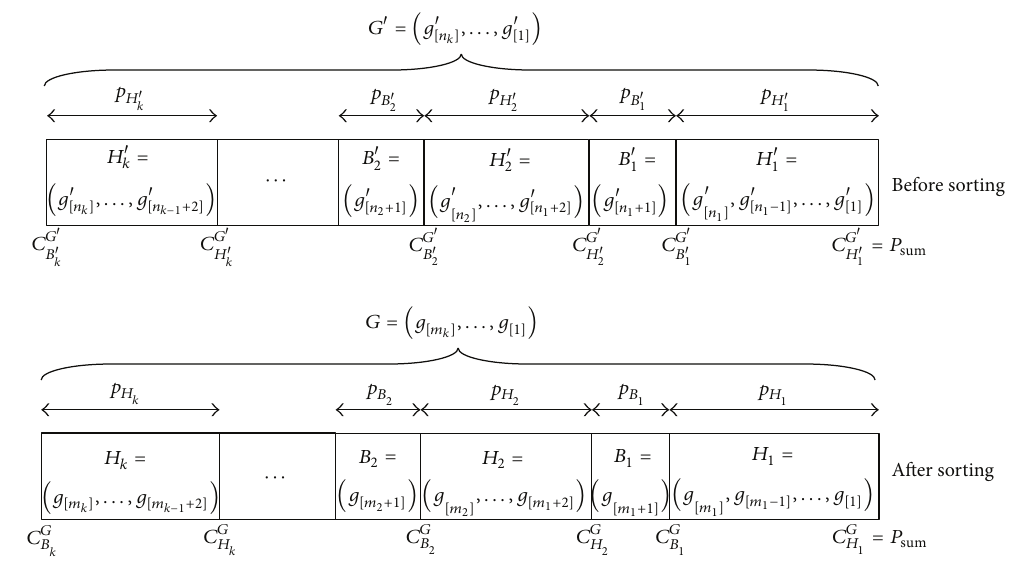
Figure 5: Sequence of tardy jobs in Case